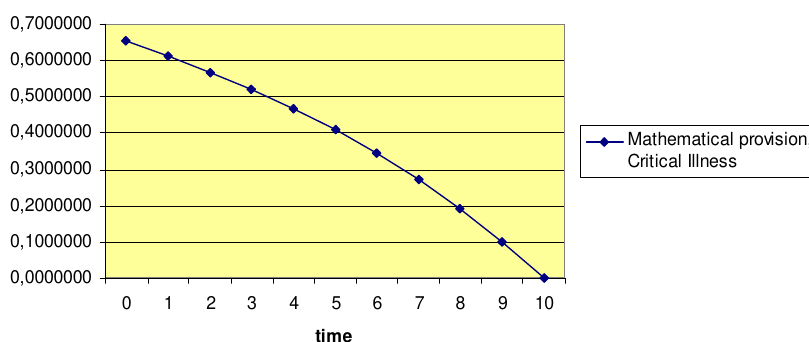
Fig. 8. Mathematical provision critical illness cover, 10 years – Poisson LC aggregation by causes of death